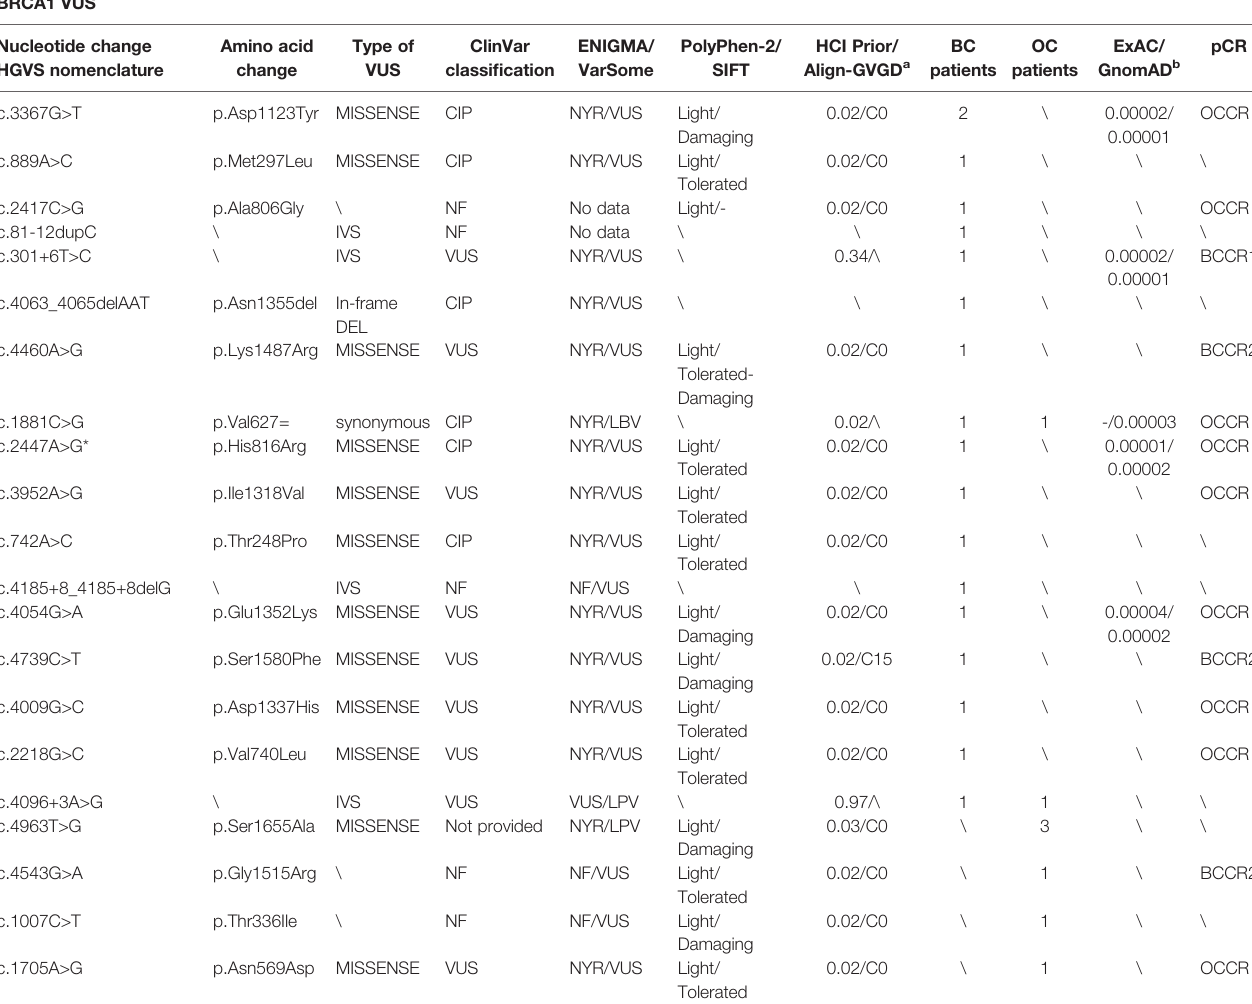
TABLE 2 | BRCA1 gene variants of unclear signi fi cance harbored by patients with breast and ovarian cancers. BRCA1